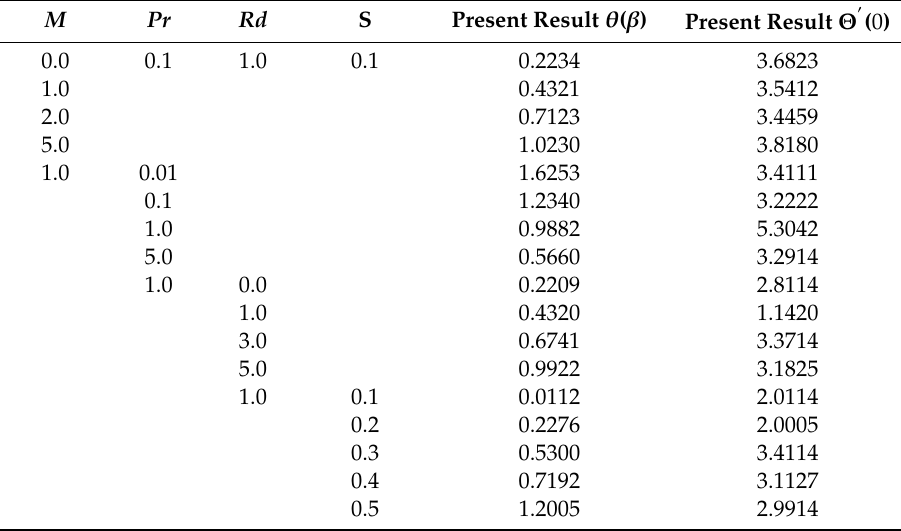
Table 8. Values of θ ( β ) dissimilar values of M , Pr , Rd and S